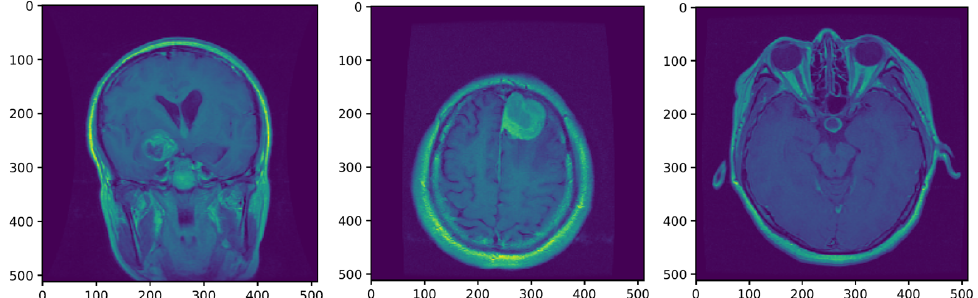
Figure 5. Axial brain samples from the public dataset given by Cheng in [81]: ( left ) glioma; ( center ) meningioma; ( right ) pituitary tumors.